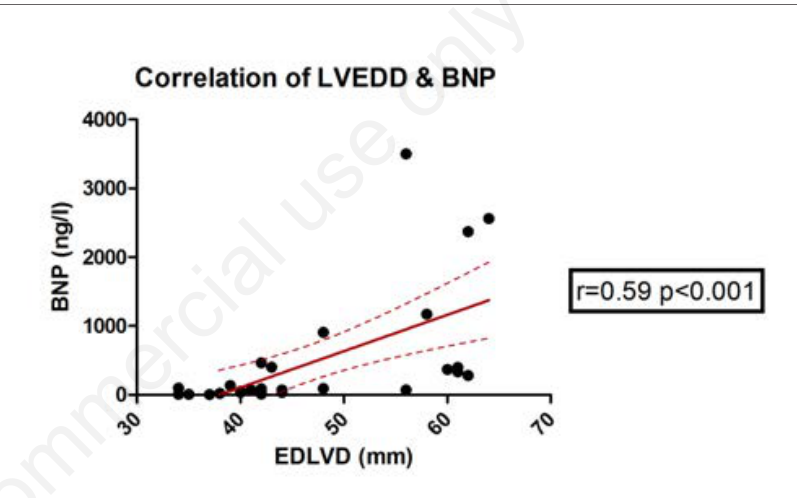
Figure 1. Association between BNP level and LVEF using linear regression (solid line). The dotted lines represent the 95% confidence band of the best-fit line. BNP, brain natriuretic peptide; LVEF, left ventricular ejection fraction.